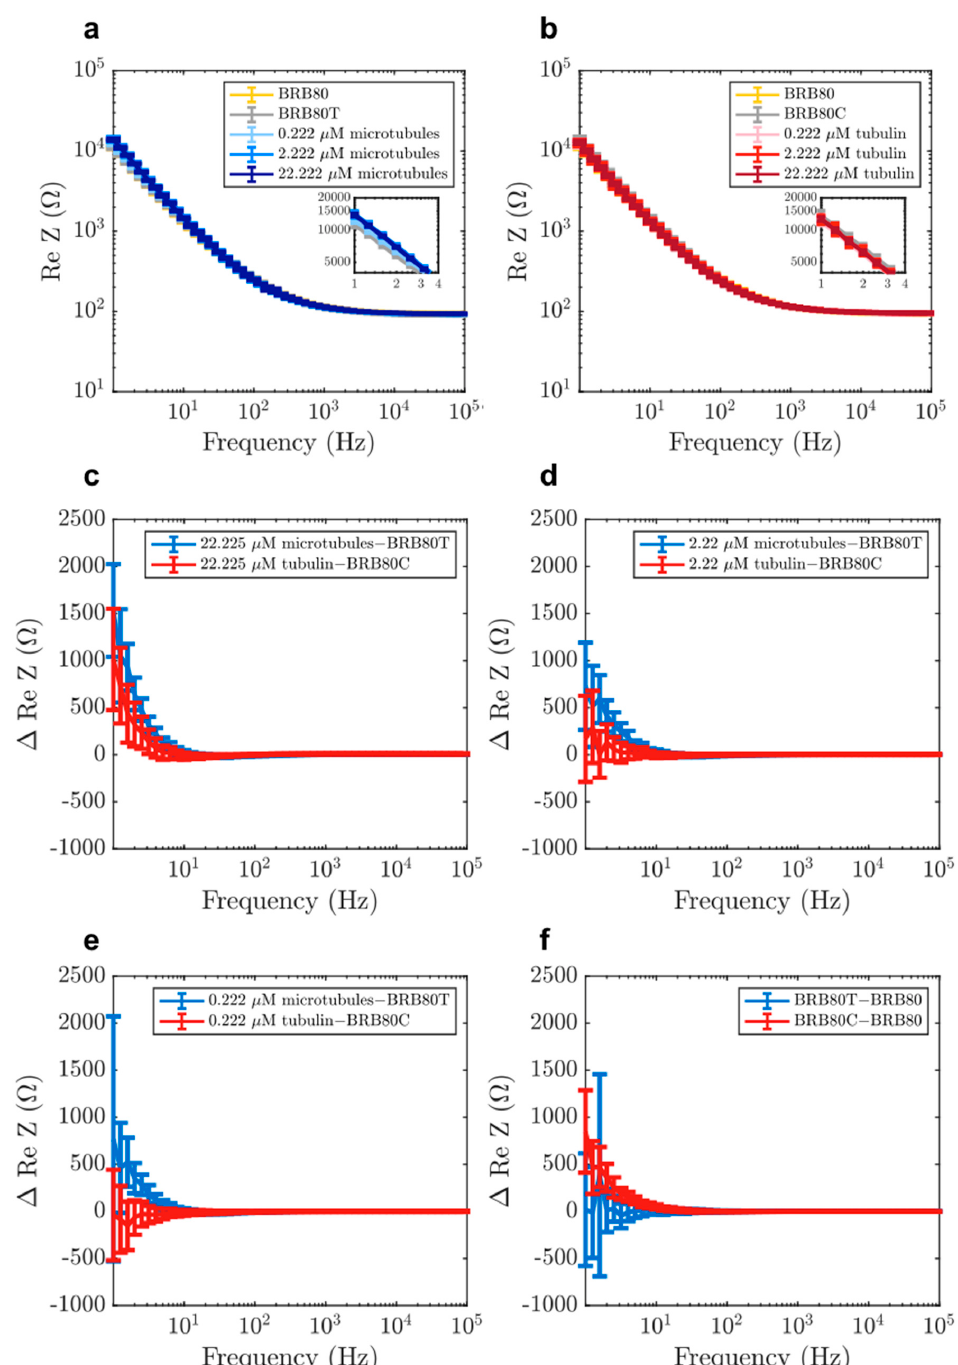
Figure 4. Examples of raw values of real component of impedance in solutions containing ( a ) MTs and ( b ) tubulin, for the purpose of displaying typical impedance values. Mean di ff erences in the real component of impedance as a function of input AC frequency at total tubulin concentrations of ( c ) 22.225 µ M (n = 22 experiments for tubulin, n = 21 for MTs), ( d ) 2.222 µ M (n = 35 experiments for tubulin, n = 49 for MTs) ( e ) 0.222 µ M (n = 35 experiments for tubulin, n = 49 for MTs), ( f ) comparison of the e ff ects of paclitaxel (BRB80T) and colchicine (BRB80C, n = 49 experiments for BRB80T, n = 35 for BRB80C, n = 84 experiments for BRB80). Error-bars represent standard